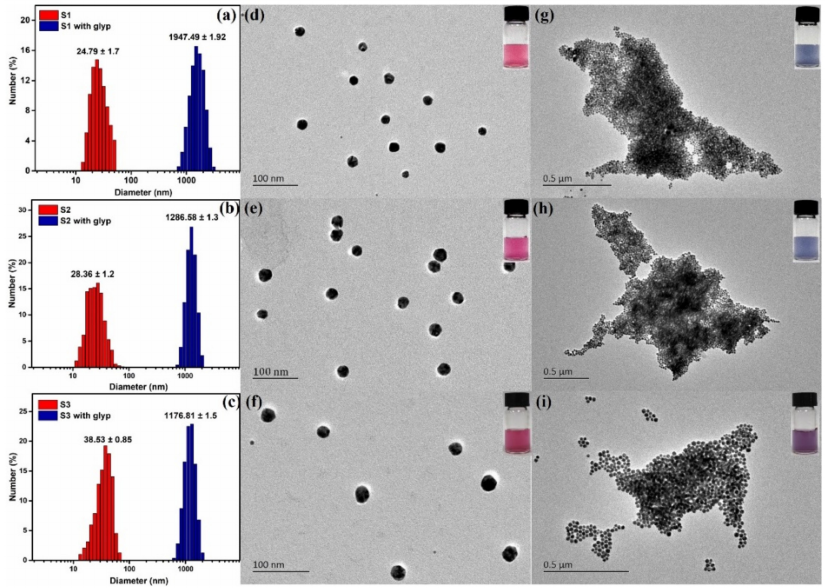
Figure 2. ( a – c ) The histograms of the nanoparticle diameter measured from DLS for S1–S3 (red) and with glyphosate (blue); TEM images of AET-AuNPs chemical sensors S1–S3 ( d – f ) and the aggregation state in the presence of 5 mM of glyphosate ( g – i